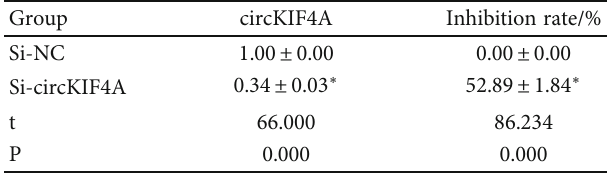
Figure 4: Impact of inhibiting circKIF4A on HGC-27 apoptosis, clone formation and migration a: Impact of inhibiting circKIF4A on HGC- 27 apoptosis. b: Impact of inhibiting circKIF4A on HGC-27 clone formation number. c: Impact of inhibiting circKIF4A on HGC-27 migration. d: Impact of inhibiting circKIF4A onBax and Bcl-2 protein in HGC-27. ∗∗∗ P < 0.001. Table 3: Detection of impacts of inhibiting circKIF4A on HGC-27 multiplication, migration and apoptosis ( (cid:1) x ± s , n = 9